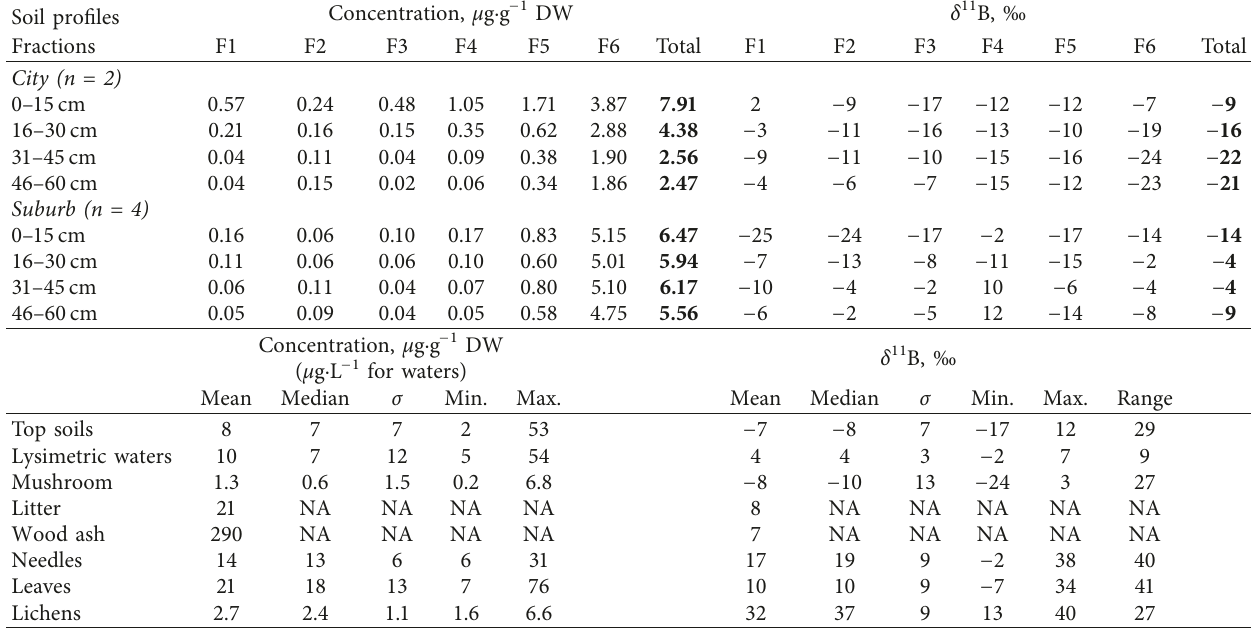
Table 4: Boron concentrations and isotopic composition in environmental samples from Lule˚a.